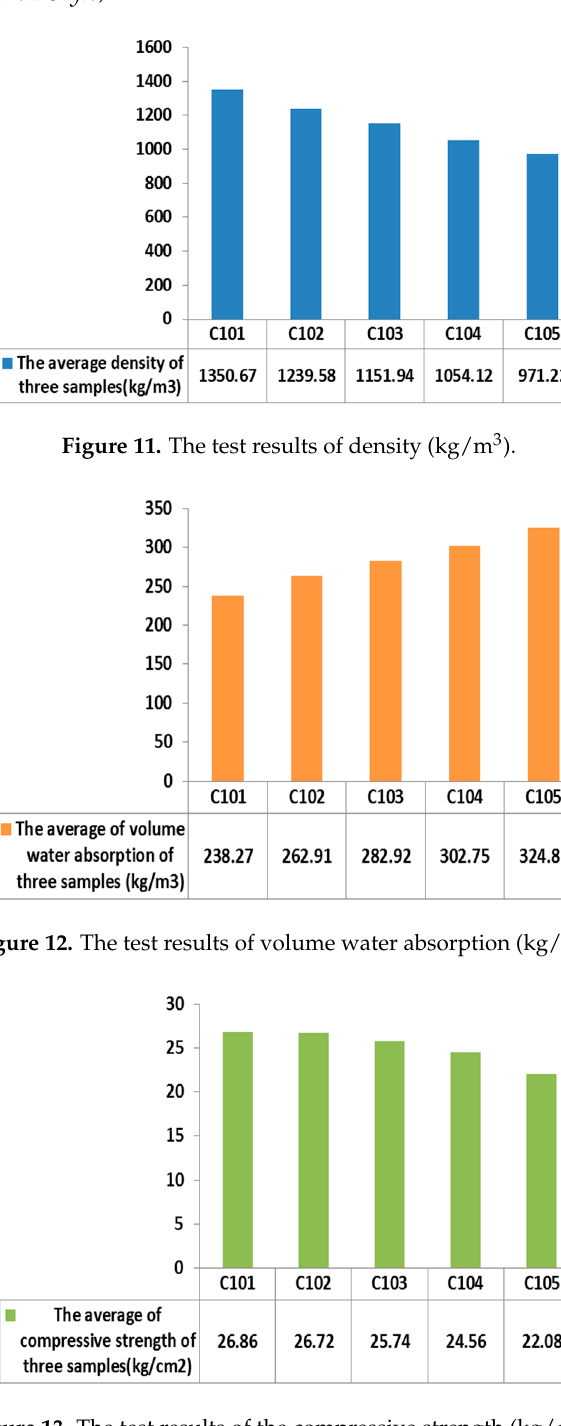
Figure 13. The test results of the compressive strength (kg/cm 2 ).